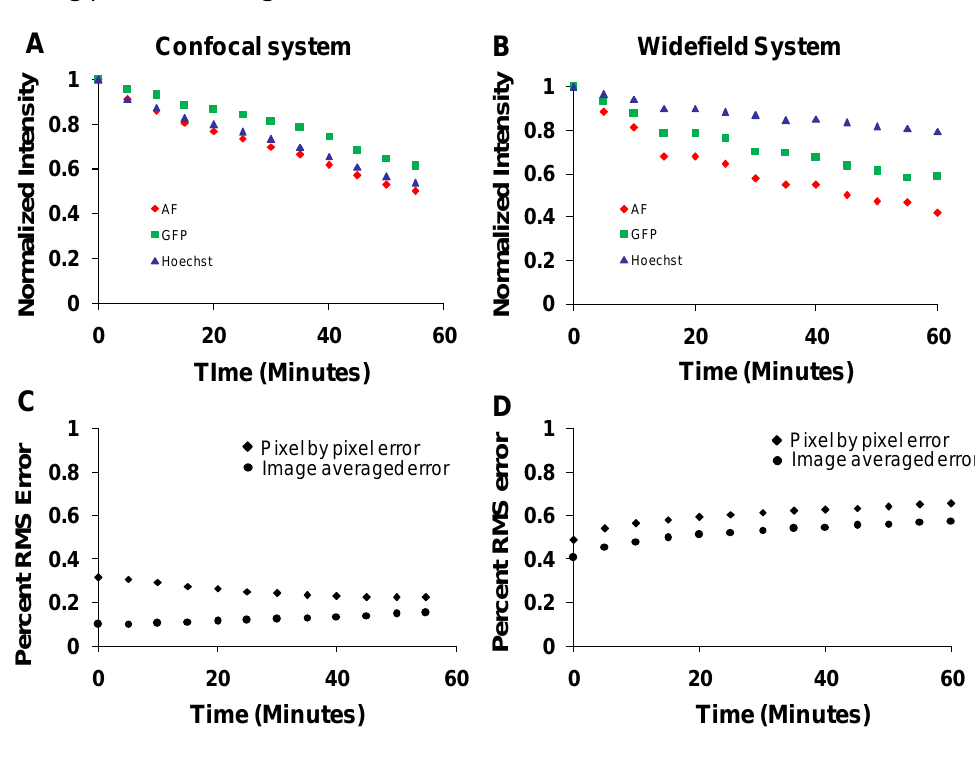
Figure 10. Photobleaching curves for average signal in each of the three spectral unmixed abundance images: autofluorescence (AF), green fluorescent protein (GFP), and Hoechst. Samples were illuminated continuously for 1 h on the hyperspectral confocal system ( A ) and hyperspectral widefield system ( B ); photobleaching rates for green fluorescent protein (GFP) and Hoechst were higher on the confocal system than on the widefield system, while photobleaching rates for autofluorescence (AF) were comparable between both systems. Percent RMS error of linear unmixing at different time points during photobleaching on the confocal system ( C ); and widefield system ( D ) during photobleaching.